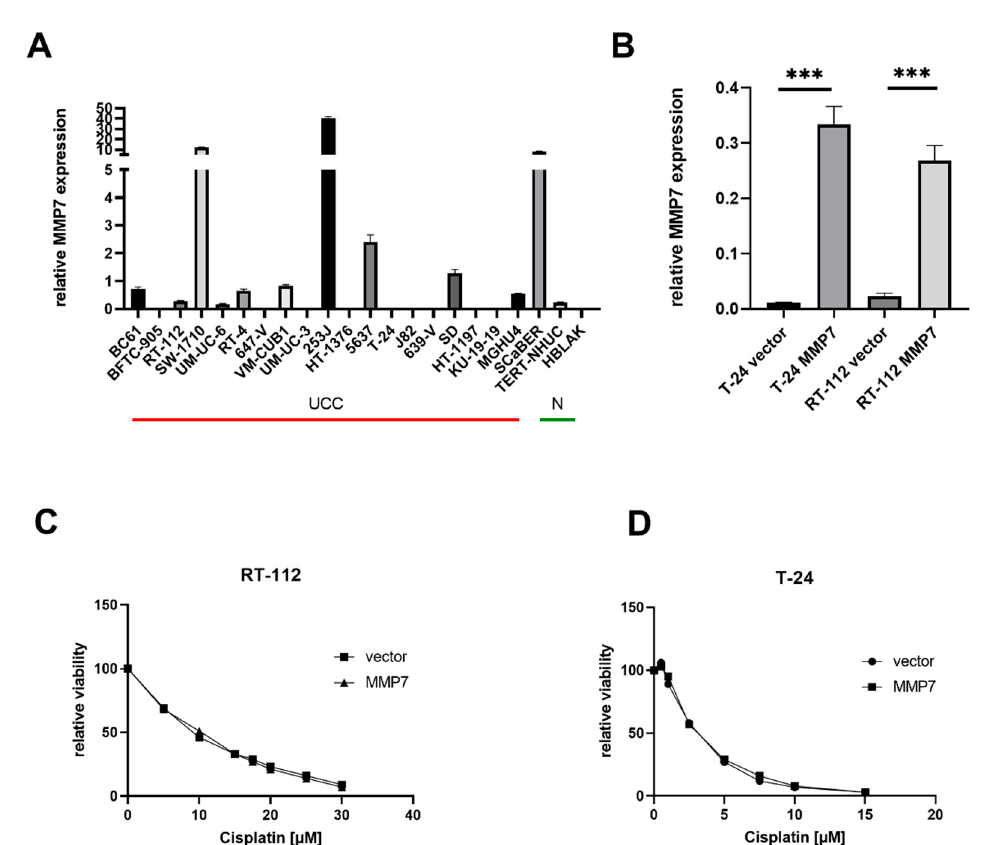
Figure 3. MMP-7 gene expression in urothelial carcinoma cells (UCCs), control cells and transfected cells and its correlation with cisplatin sensitivity. ( A ) Expression of MMP-7 was measured by RT-qPCR in triplicates and normalized to the reference gene TATA-Box binding protein ( TBP ). Expression of 20 bladder cancer (BC) cell lines (UCCs, red line) was compared to two normal control cell lines (N, green line). *** marks statistical significance with p < 0.001. ( B ) Verification of stable overexpression of MMP-7 in UCC T-24 and RT-112 by RT-qPCR. Expression of MMP-7 was measured by RT-qPCR in quadruplicates (technical duplicates from two biological replicates) and normalized to the reference gene TBP. ( C , D ) Cisplatin sensitivity of MMP-7 overexpressing UCCs. Cell viability was measured in quadruplicates by CellTiter Glo assay, 72 h after treatment, with indicated cisplatin doses. Viability of MMP-7 overexpressing cells was normalized to vector control cells. One representative result of three independent experiments is displayed.